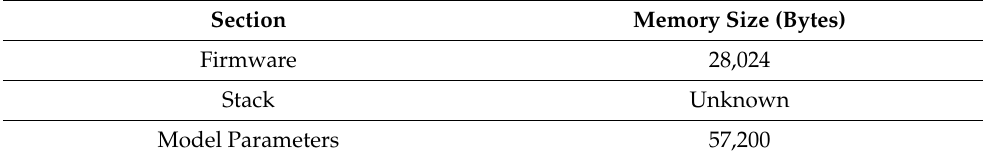
Table 5. IOb-SoC ECG-ID-BNet SRAM section memory size.